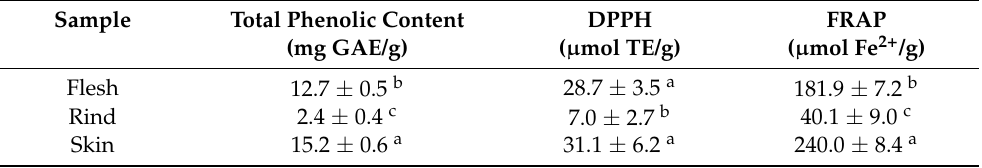
Table 1. Total phenolic content and antioxidant activity of watermelon parts.